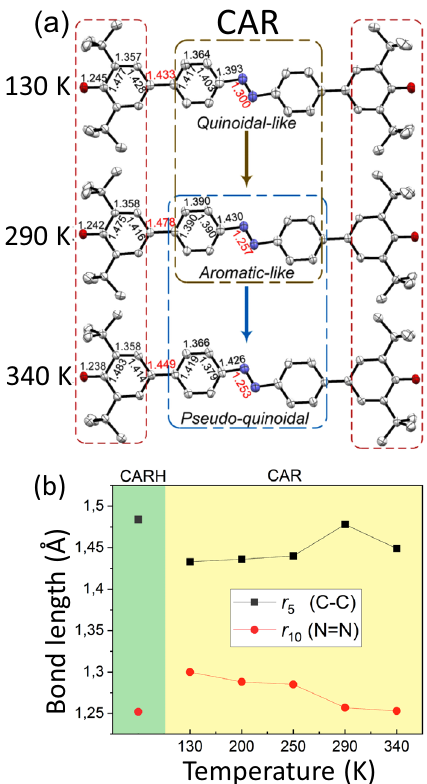
Fig. 2 Temperature-dependent single-crystal structures of CAR. a Single- crystal X-ray structure with selected bond lengths of CAR at 130, 290, and 340 K with thermal ellipsoids at the 50% probability level. H atoms are not shown for clarity. b Selected bond lengths (Å) values of CARH and